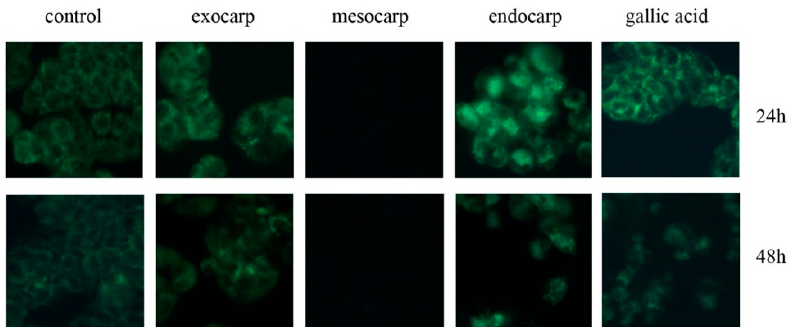
Figure 4. Litchi exocarp and endocarp extracts induce intracellular vacuolization. Cells (7 × 10 3 ) were treated with 150 µg/mL GAE litchi extracts or 60 µg/mL gallic acid for the indicated times. Afterward, cells were incubated with 50 µM monodansylcadaverine (MDC) for 10 min, washed with phosphate- buffered saline (PBS) and visualized under a fluorescence microscope equipped with a 4 ′ ,6- diamidino-2-phenylindole (DAPI) filter at a magnification of 400×. Micrographs are representative of almost three fields from two independent experiments.